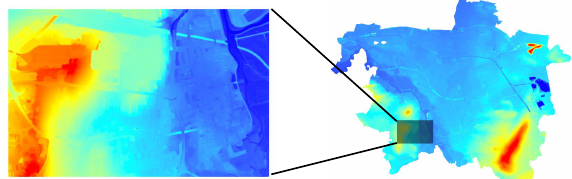
Figure 3. DTM of Hannover-Ricklingen (left) and Hannover (right) in 0.5 m resolution